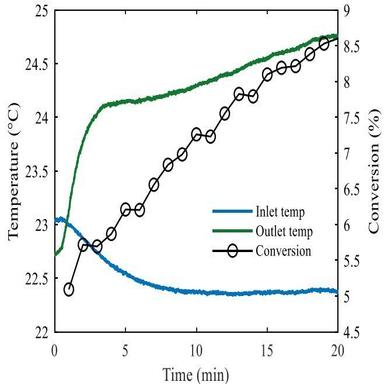
Example of transient kinetics for the silver screen catalyst. The graph shows the outlet temperature of the differential reactor and the conversion over a 25 min period.